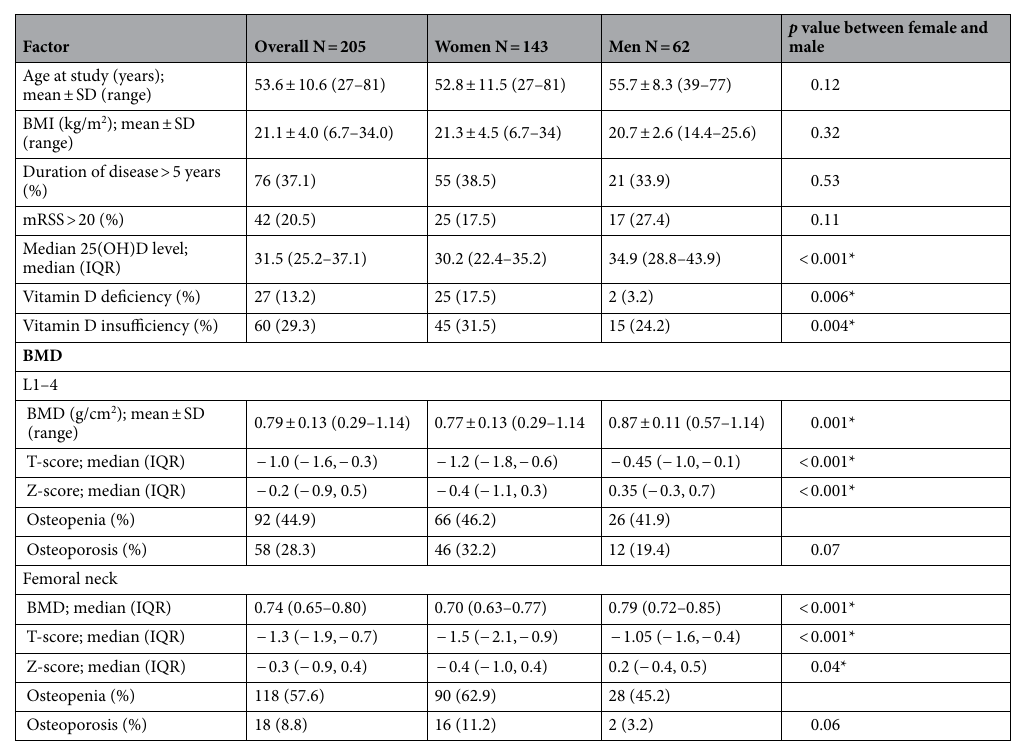
Table 1. Clinical characteristics classified by sex. BMI Bone mass index, mRSS Modified Rodnan skin score, BMD Bone mineral density, L1–4 Lumbar spine level 1–4. *Statistical